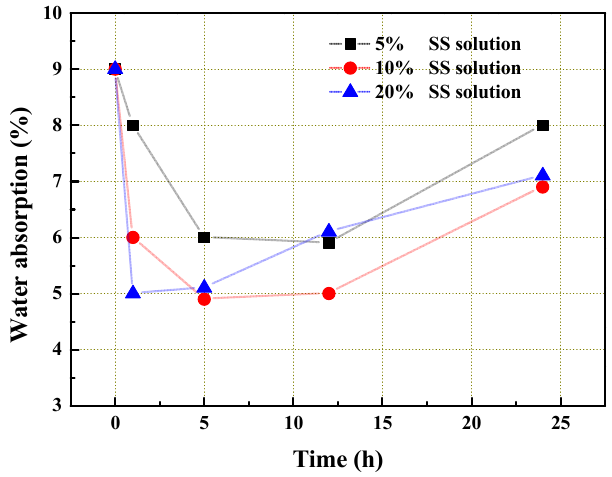
Figure 6. The water absorption of the coral aggregate that was treated with the SS solution.